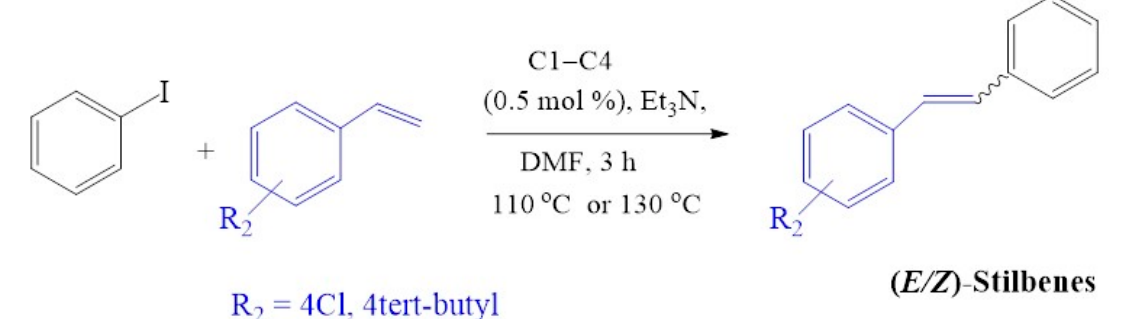
Figure 14. Mizoroki-Heck cross-coupling of iodobenzene with 4-chlorostyrene and 4-tert-butylstyrene using pre-catalysts C1 – C4 .